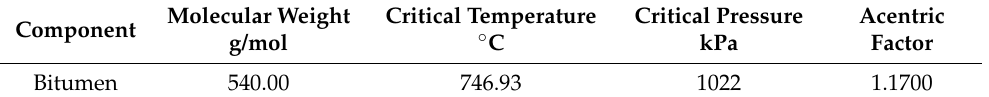
Table 2. Basic properties of bitumen.